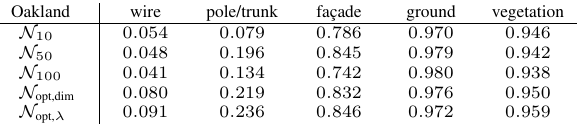
Table 5: Precision values for RF-based classification using all features and different neighborhood definitions.